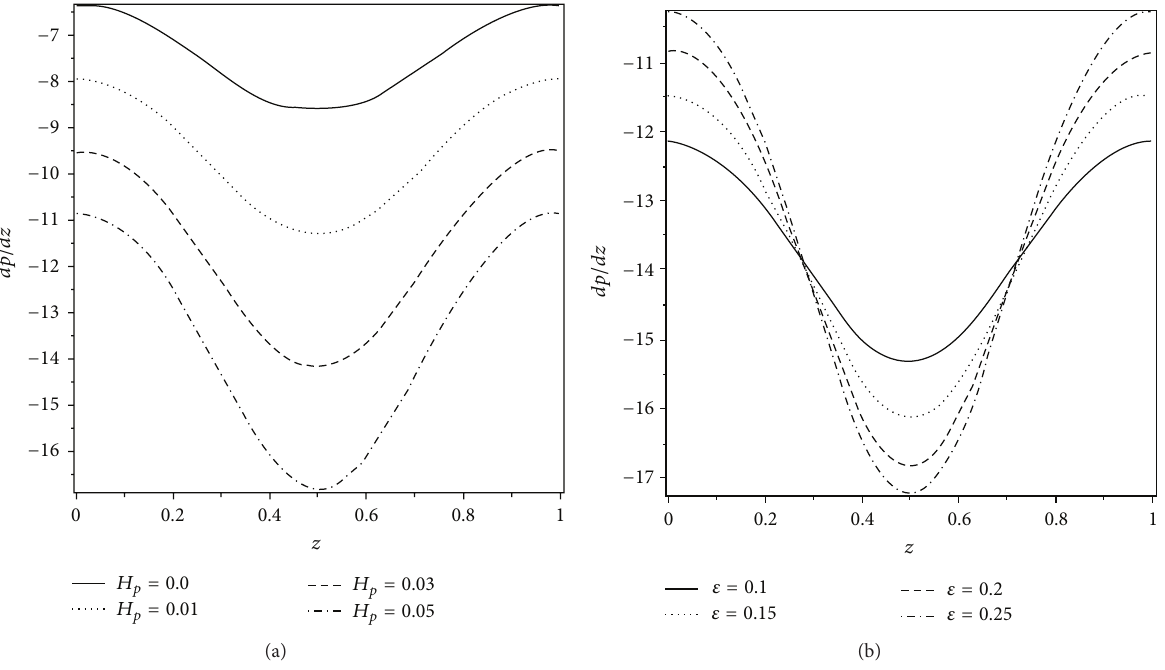
Figure 6: Variation of axial pressure gradient 𝑑𝑝/𝑑𝑧 for different values of (a) 𝐻 𝑝 when 𝜀 = 0.2 and (b) 𝜀 when 𝐻 𝑝 = 0.05 . The other parameters are 𝛼 = 0.4 , 𝛽 = 0.4 , and 𝑄 = 0.95 .